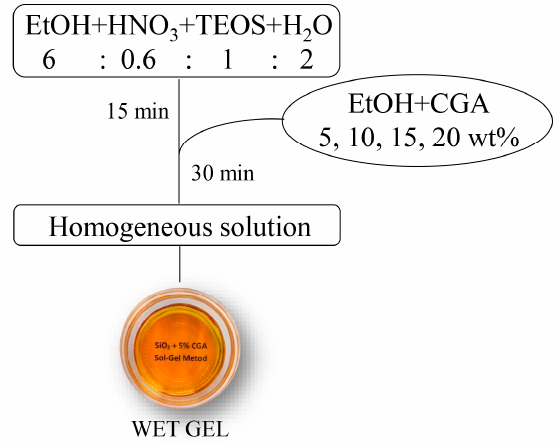
Figure 10. Flowchart of the sol–gel process used to synthesize the SiO 2 -CGA hybrids.